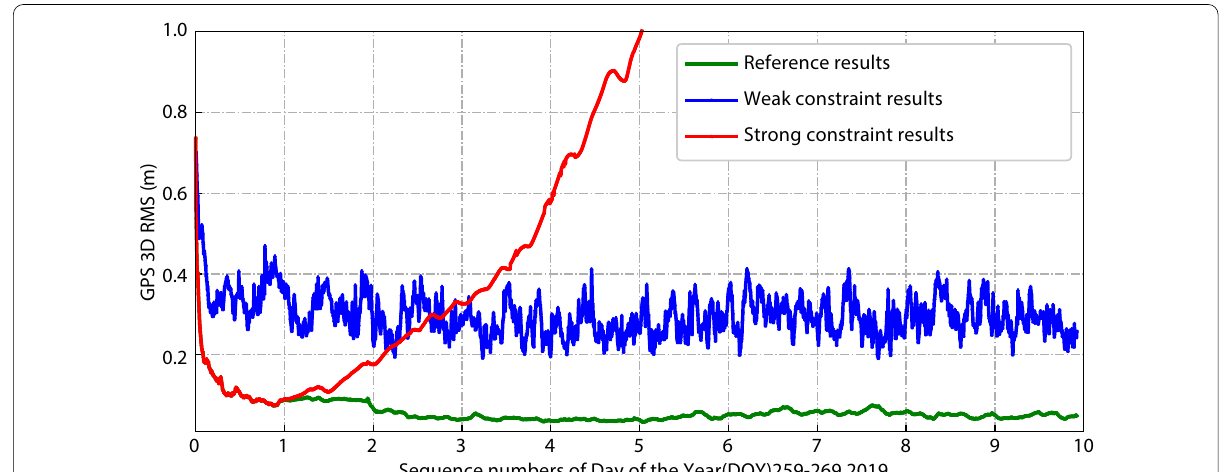
Fig. 3 Filtering orbit determination-based average 3D RMS error time series considering the different dynamic process noise levels